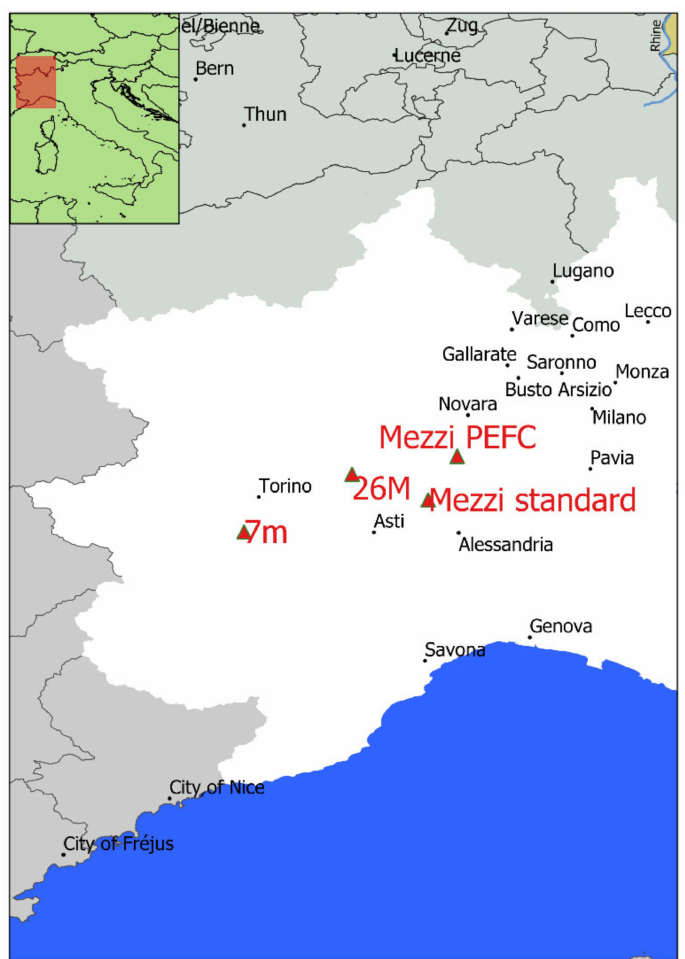
Figure 2. Locations of the field experiments (North-West Italy). Red triangle=locations of field experi-